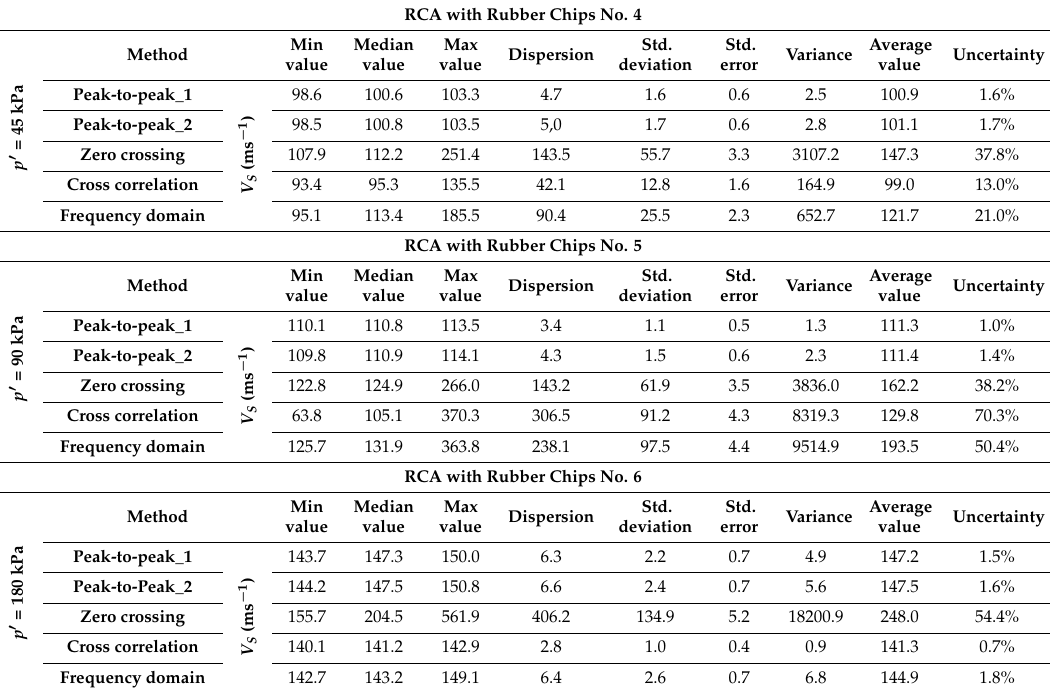
Table 6. Result of statistical analysis of mixtures of RCA with rubber chips from different methods of travel time identification in bender element